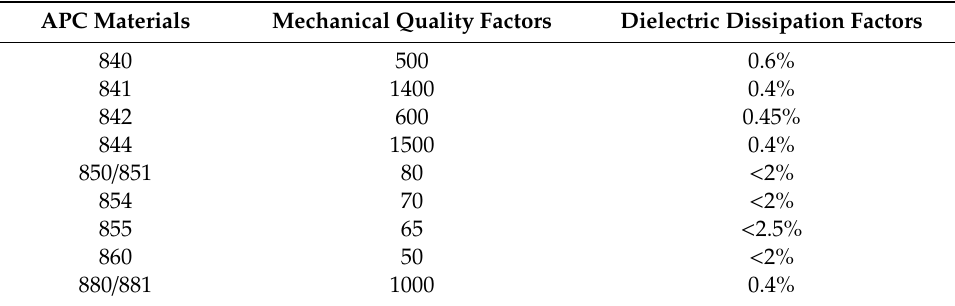
Table 2. Physical properties of APC materials